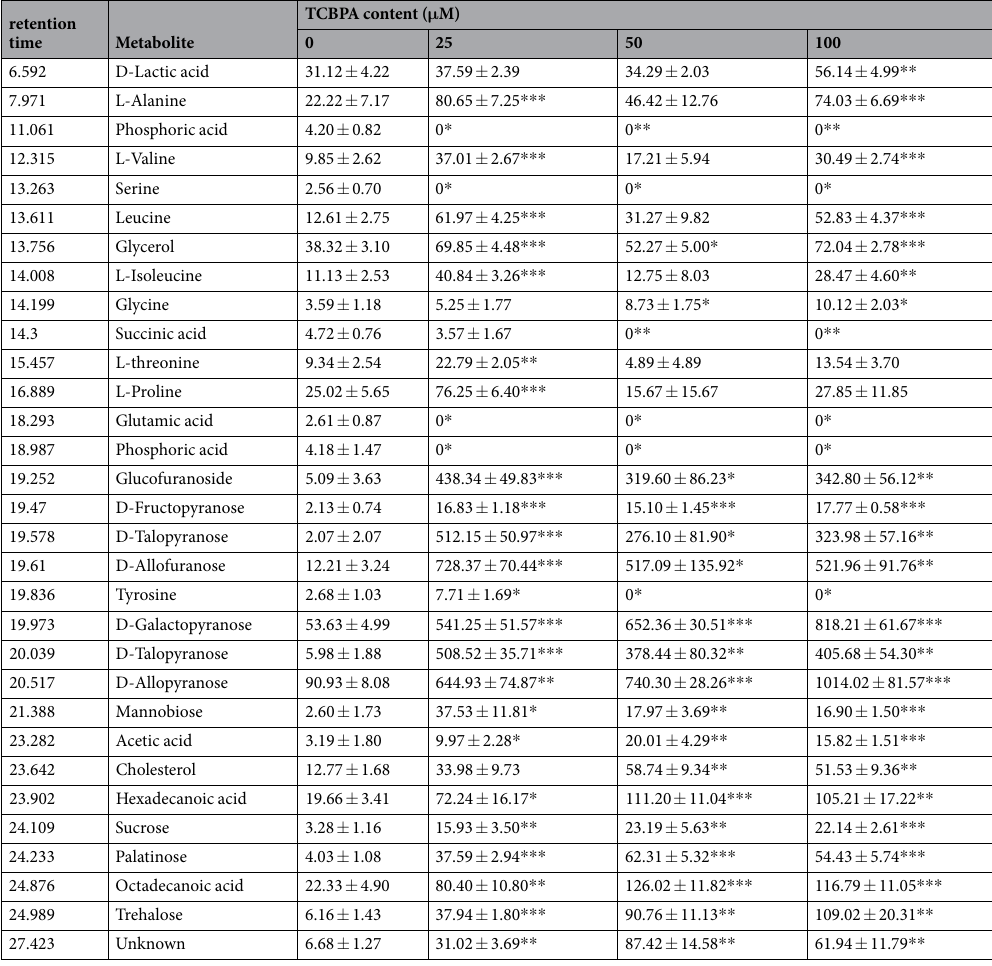
Table 1. The intracellular metabolites of Saccharomyces cerevisiae identified by GC-MS that differ between the control group and the TCBPA-treated groups. The VIP scores of all listed metabolites are greater than 1. The data represents the relative peak intensity and are presented as the mean ± SEM. * P < 0.05 compared with the control. ** P < 0.01 compared with the control. *** P < 0.001 compared with the